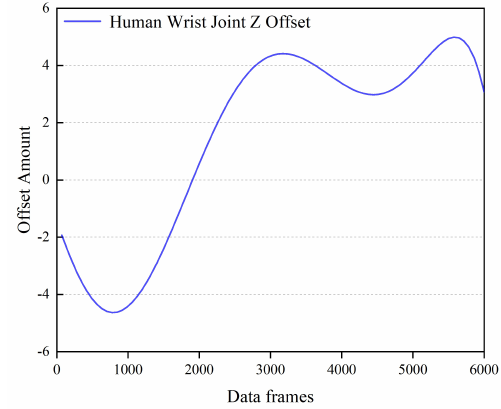
Figure 9. WRIST joint z axis offset